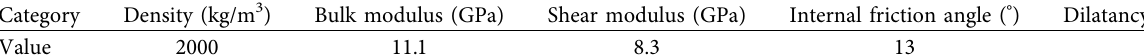
Table 3: Mechanical parameters of main rock materials in the goaf.